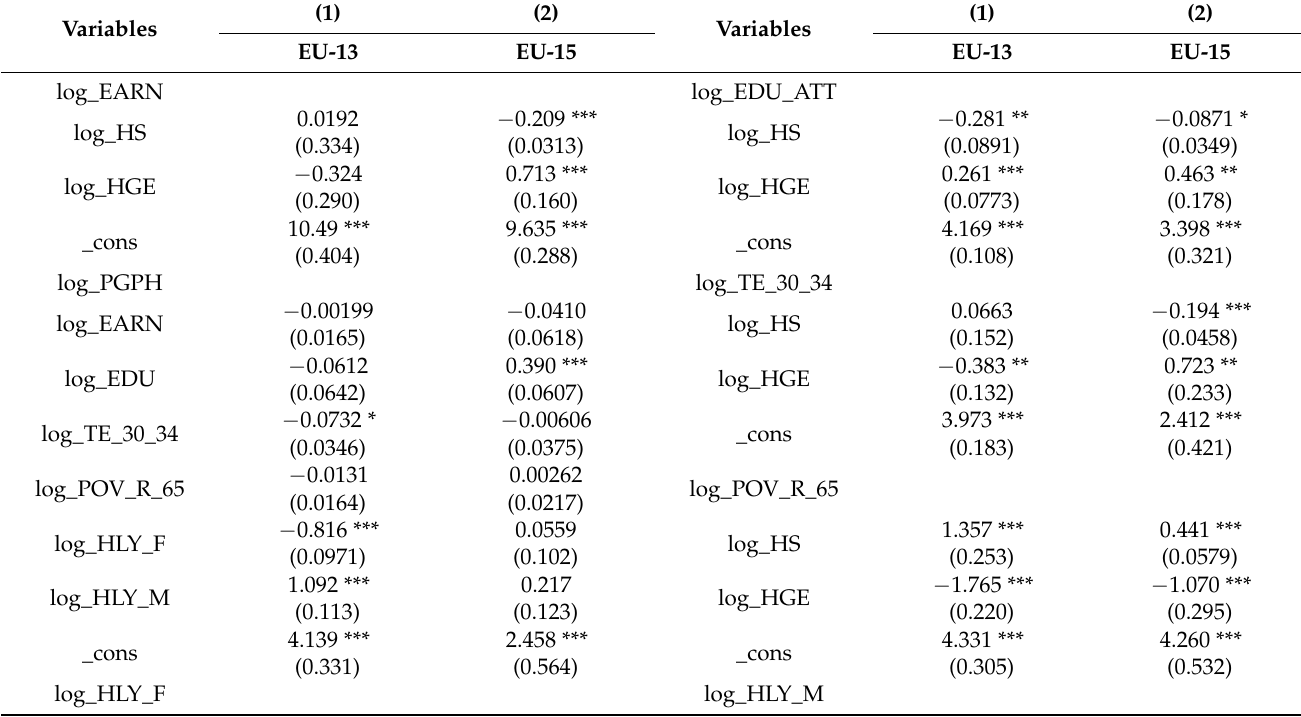
Table A2. Detailed results of the SEM models, EU-13 and EU-15,